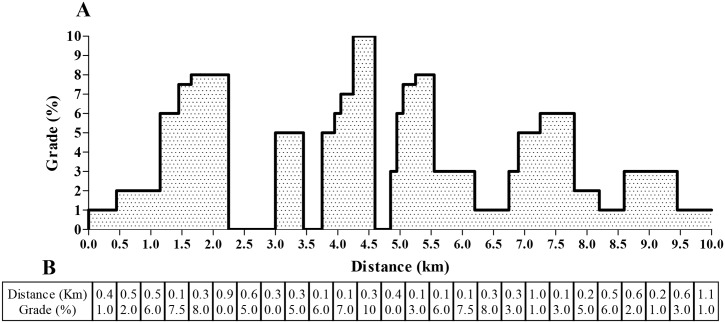
Computer-simulated course showing the (A) overall and (B) specific distance and gradient profile used in this study.